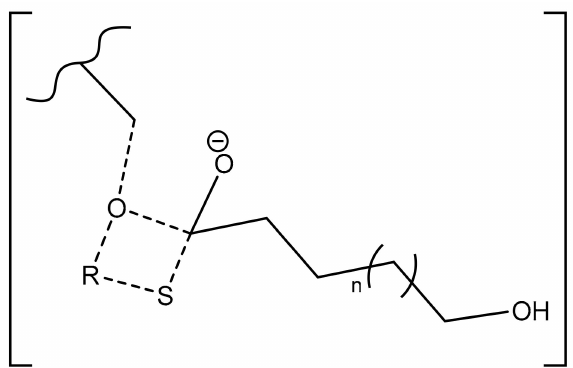
Figure 8. Potential intermediate formed in the enzymatic polymerization deacylation step that could lead to either a thioester- or an ester-initiated